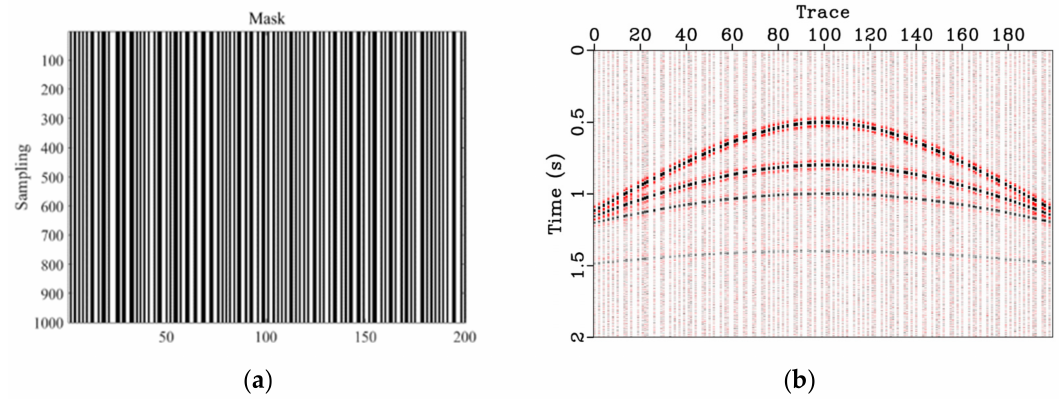
Figure 5. Mask jitter matrix. ( a ) The 50% jittered undersampling matrix (removed outlier trace). ( b ) The decimated synthetic model with 50% removed traces (with outlier noise).